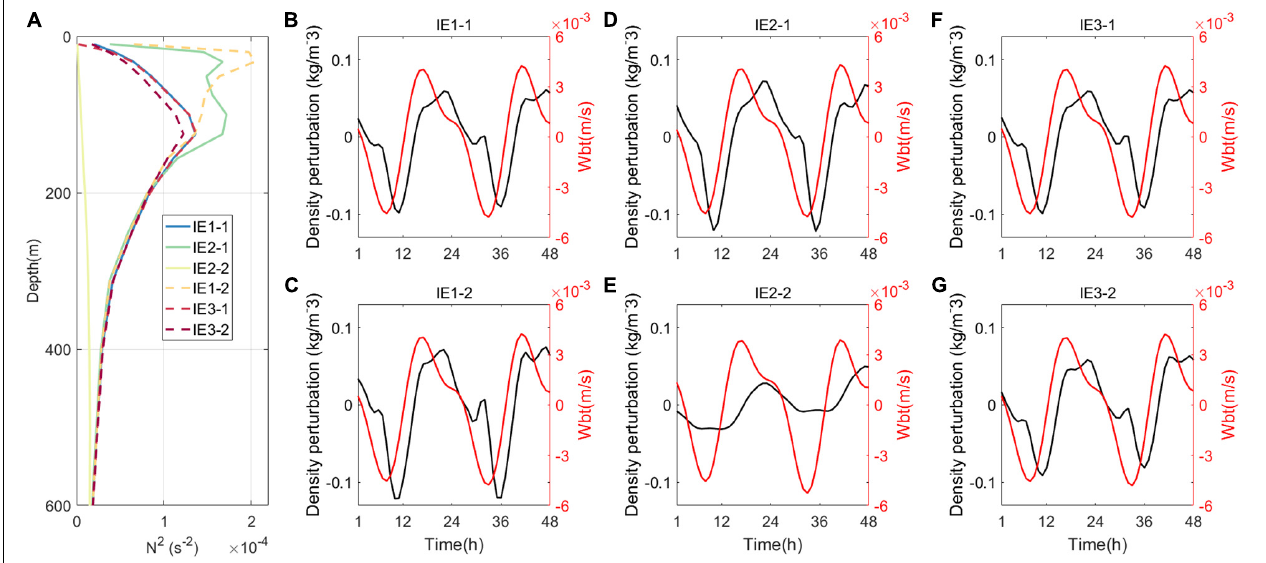
FIGURE 6 | Distributions of (A) buoyancy frequency in the center of the Luzon Strait (LS) (20.0 ◦ N, 121.0 ◦ E) for two groups of experiments and vertically averaged density perturbation and vertical barotropic velocity at the same site for (B,C) IE1, (D,E) IE2, and (F,G)